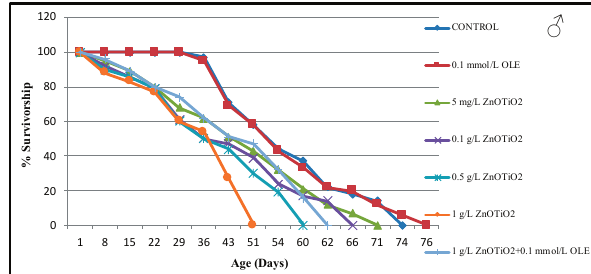
Figure 3. Exposure to ZnOTiO 2 and OLE in male adult D. mela- nogaster leads to lifespan